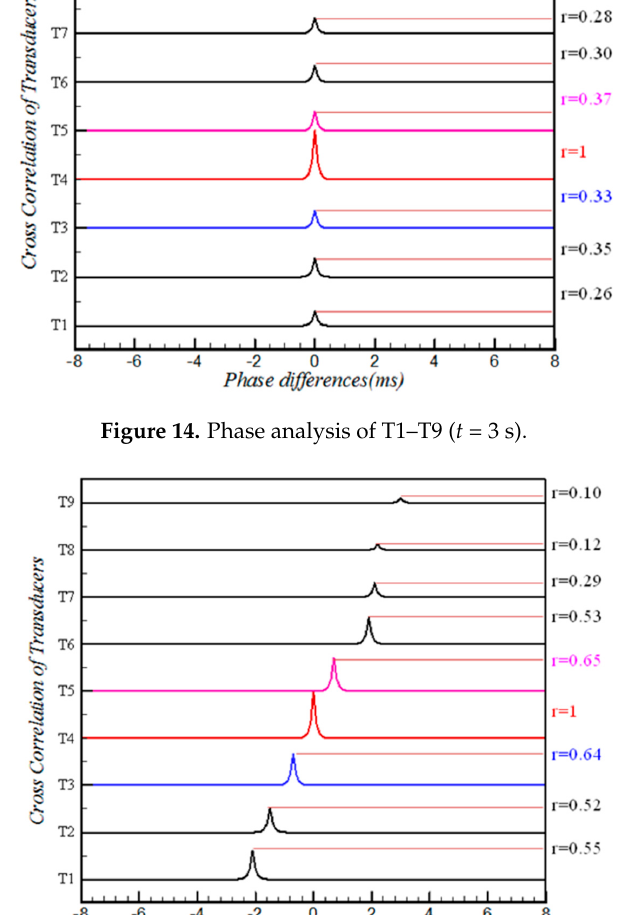
Figure 16. Phase analysis of T1–T9 and the grayscale ( t = 3 s).